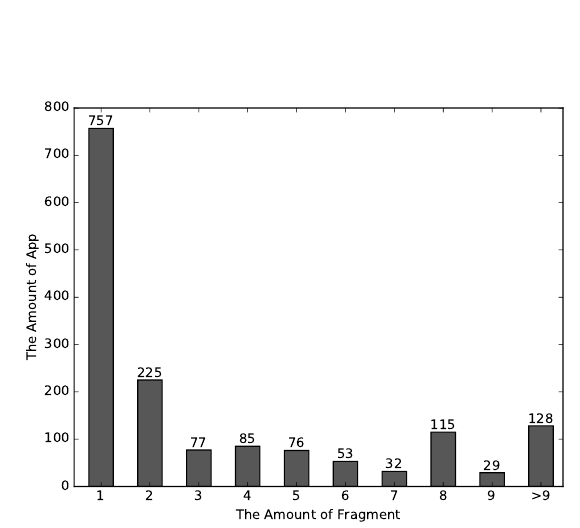
Figure 8. Distribution of The Number of